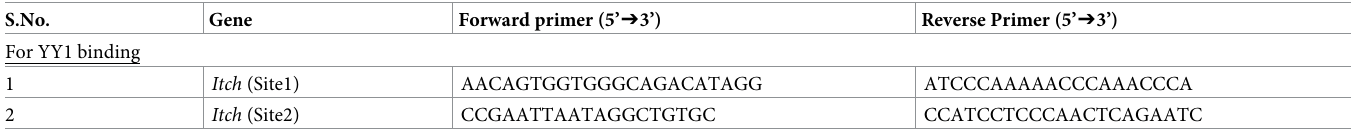
Table 2. Primer sets used for ChIP